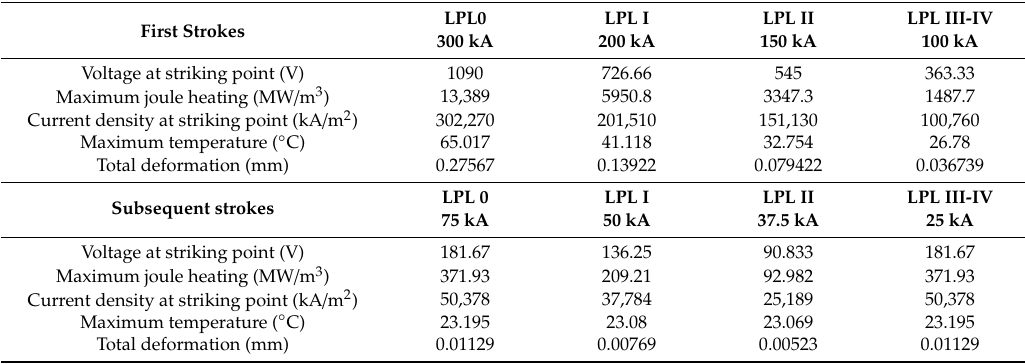
Table 4. Results obtained from the first and subsequent return strokes for Case Study C .